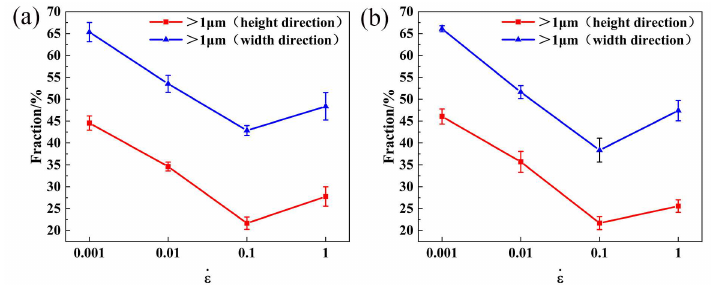
Figure 16. Statistics of phases in samples with different deformation conditions: ( a ) 380 °C, ( b ) 440 °C.